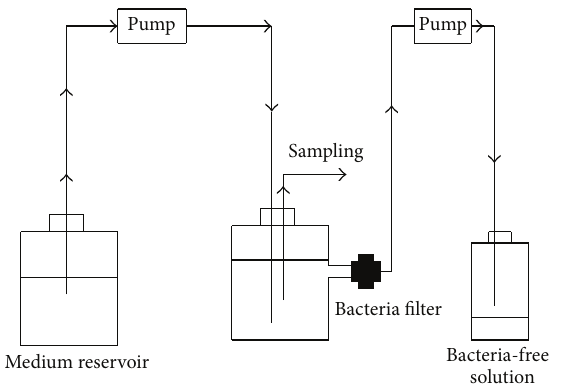
Figure 1: Configuration of the chemostat-like model to evaluate double and triple antibiotic combinations by time-kill assay in vitro . The bottles were connected to two IV infusion pumps via IV infusion sets. The first pump delivers fresh medium to the bottles at 10 mL/h to provide nutrients and continuously dilute the antibiotics. A second pump was connected to the bottle through disposable syringe bacterial filter to withdraw the medium without the bacteria at 10mL/h flow